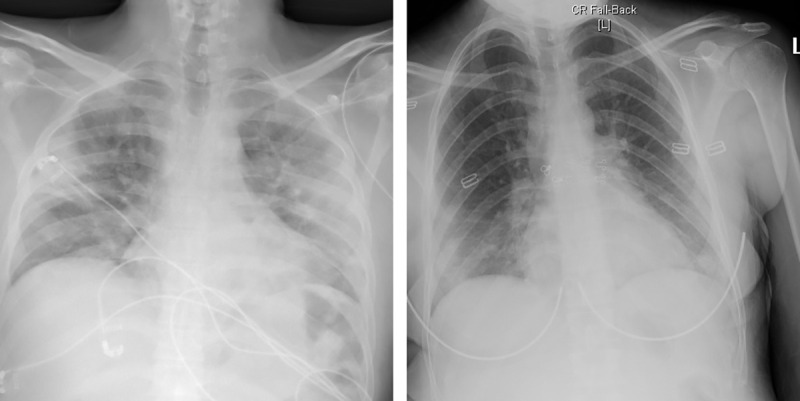
CXR’s of two different patients showing the most common abnormalities: Bilateral, peripheral ground glass opacities and consolidation.